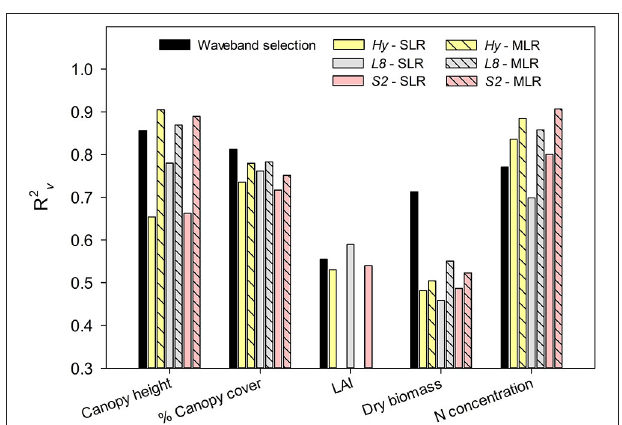
FIGURE 4 | Comparison of predictive performance (R 2 v ) given by waveband selection procedure, and Hyperspectral ( Hy ) indices and synthesized Landsat-8 ( L8 ) and Sentinel-2 ( S2 ) indices with simple linear regression (SLR) and multilinear regression (MLR) models, for estimation of different canopy parameters of finger millet. Within each group, SLR models with the best statistics were selected for